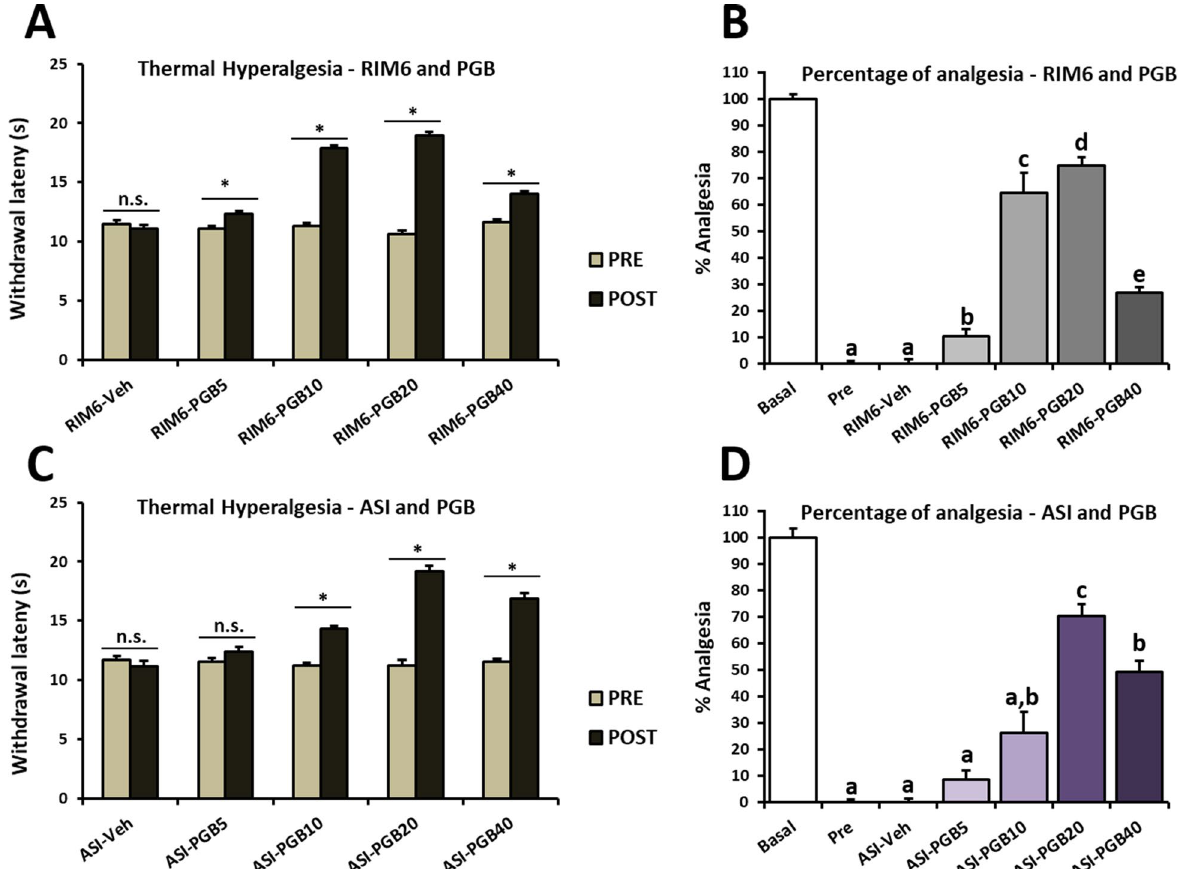
Figure 7. Dose–response effect of pregabalin acute treatment on mice subjected to reserpine-induced myalgia and intramuscular acid saline solution injection. Hind paw withdrawal latency in response to a thermal stimulus pre- and after Pregabalin administration in the (A) RIM6 and (B) ASI models and (C,D) percentage of analgesia 30 min after administration at 28 (RIM6) or 10 (ASI) days postinduction. Data are expressed as the mean ± SEM (n = 5 per group). * p < 0.05 Pre versus Post; n.s. = no significant differences; a–e: Groups not sharing a letter showed significant differences, p < 0.05, by post hoc